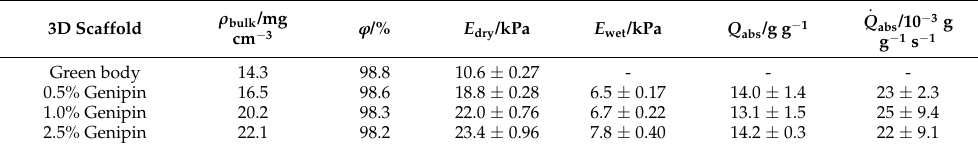
Table 1. Physical and mechanical properties for scaffolds with different cross-linker concentration and before cross-linking (green body): bulk density, ρ bulk , porosity, ϕ , Young’s modulus under dry conditions, E dry , and in culture medium, E wet , water absorption capacity, Q abs , and water absorption . Q abs . rate,